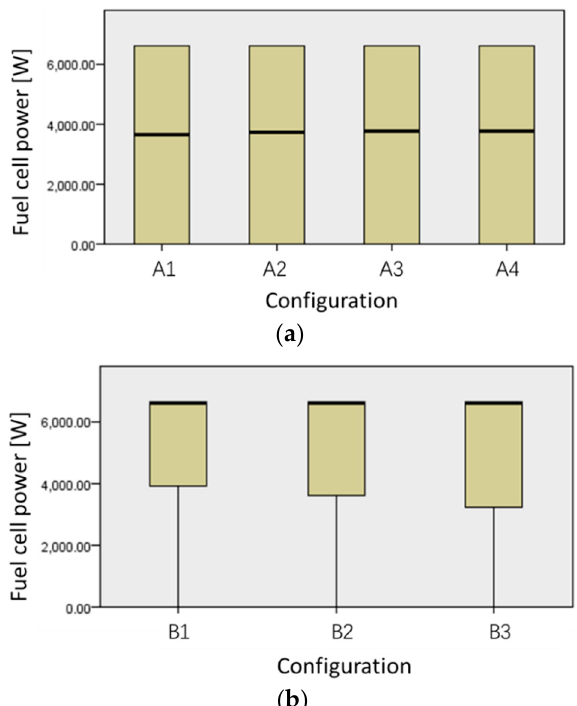
Figure 15. Box charts of fuel cell power under ( a ) Configurations A1–A4 and ( b ) Configurations B1–B3.